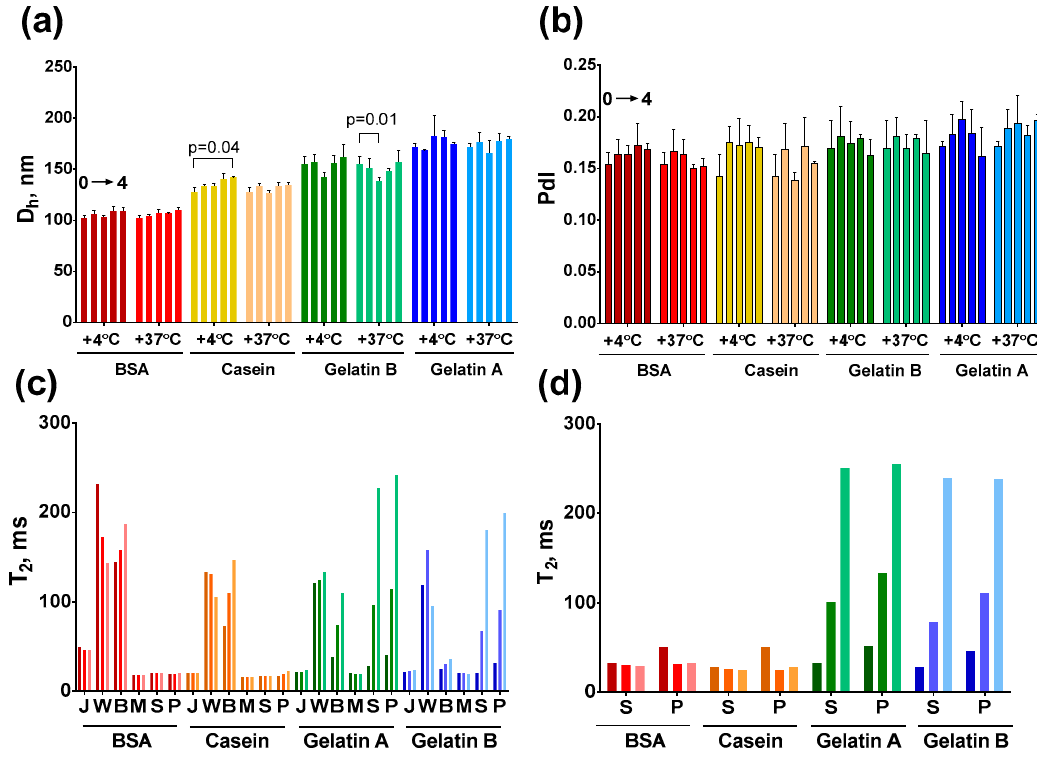
Figure 9. Storage stability of Fe@C-NH 2 /Protein/G and stability of Fe@C-NH 2 /Protein/G and Fe@C-NH 2 /Protein/Str in complex media. Upper row: changes in hydrodynamic diameter ( a ) and polydispersity index ( b ) during four weeks of storage at different temperatures; the five bars represent the size or PdI at week 0, 1, 2, 3, and 4 (from left to right), statistics: two-way ANOVA with Dunnet’s post-hoc test, n = 3, mean ± SD; lower row: the T2 of Fe@C-NH 2 /Protein/G ( c ) and Fe@C-NH 2 /Protein/Str ( d ) diluted in juice (J), wine (W), beer (B), milk (M), blood serum (S), and plasma (P); the three bars represent T2 at 0, 1, and 5 h (from left to right).